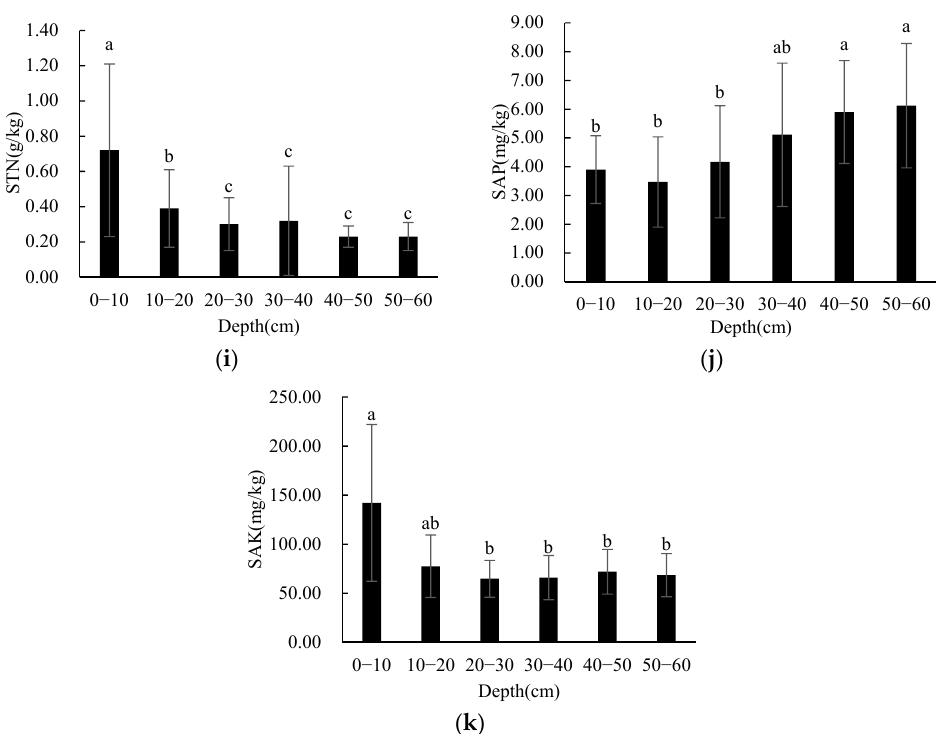
Figure 2. One-way ANOVA results of soil physicochemical properties at different depths (a–k describe distribution characteristics of SBD(a), Soil Porosity(b), Soil Sand(c), Soil Silt(d), Soil Clay(e), Soil pH(f), SOM(g), Soil C/N(h), STN(i), SAP(j), SAK(k), respectively; different letters denote significant differences; p < 0.05; a > b > c > d).